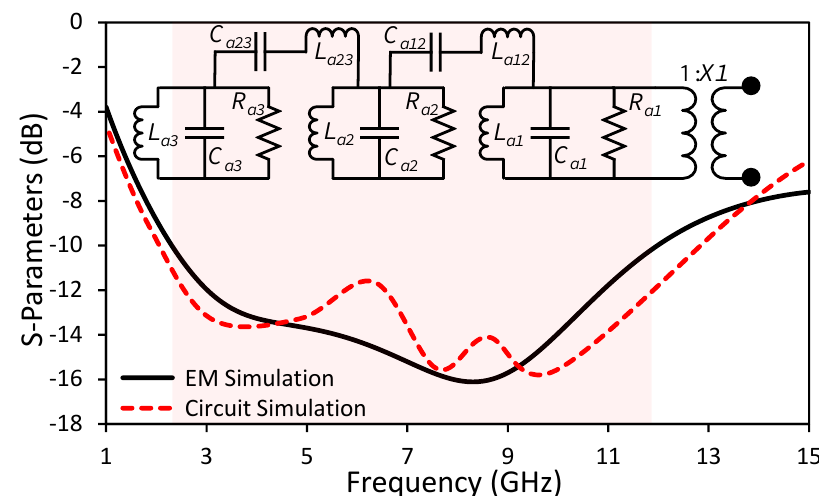
Figure 3. Lumped element equivalent circuit model ( R a 1 = 295 Ω , R a 2 = 54.45 Ω , R a 3 = 60 Ω , C a 1 = 3.45 pF, C a 2 = 3.82 pF, C a 3 = 4.8 pF, L a 1 = 1.55 nH, L a 2 = 7.42 nH, L a 3 = 3.85 nH, L a 12 = 0.6 nH, C a 12 = 1.5 pF, L a 23 = 0.7 nH and C a 23 = 1.22 pF) and comparison of EM and circuit model